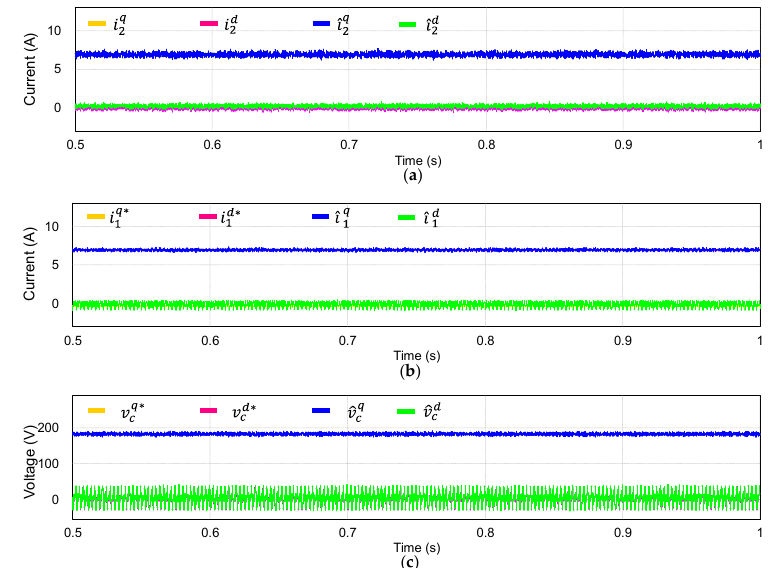
Figure 7. Simulation results of the estimated states with the proposed controller under three-phase distorted grid voltages. ( a ) Waveforms of measured and estimated grid-side currents at the SRF; ( b ) waveforms of reference and estimated inverter-side currents at the SRF; and ( c ) waveforms of reference and estimated capacitor voltages at the SRF.